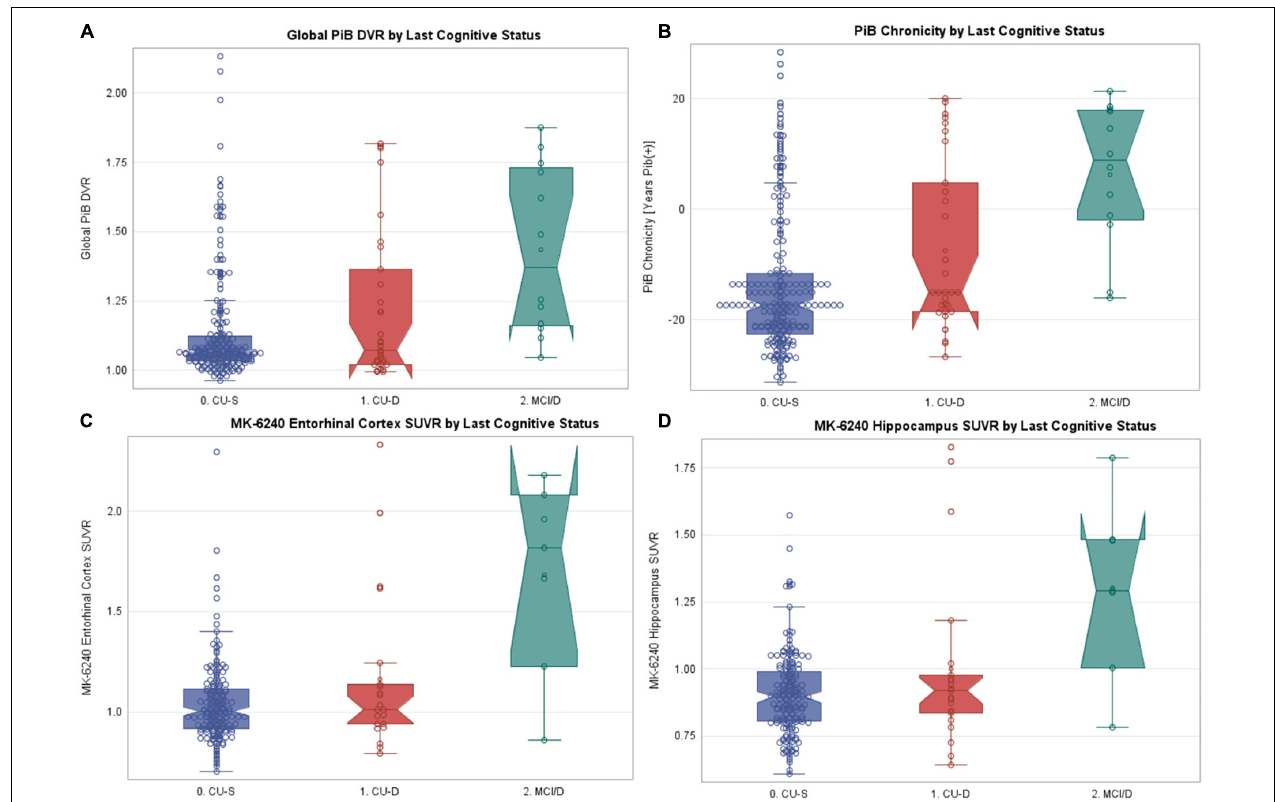
FIGURE 5 | PET PiB, PiB chronicity and MK-6240 values by last cognitive status. Notched boxplots of amyloid and tau PET data, where notches represent the median ± 1.58*(interquartile range/square root of n ). (A) Most recent global PET PiB DVR value by most recent cognitive status. (B) Estimated PiB chronicity at time of most recent cognitive status. (C) MK-6240 entorhinal cortex SUVR by most recent cognitive status. (D) MK-6240 hippocampal SUVR by most recent cognitive status. CU-S, cognitively unimpaired-stable; CU-D, cognitive unimpaired-declining; MCI/D, MCI or dementia. N’s within the CU-S, CU-D, and MCI/Dementia groups were, respectively 219, 31, 12 for PET PiB, and 181, 21, 7 for